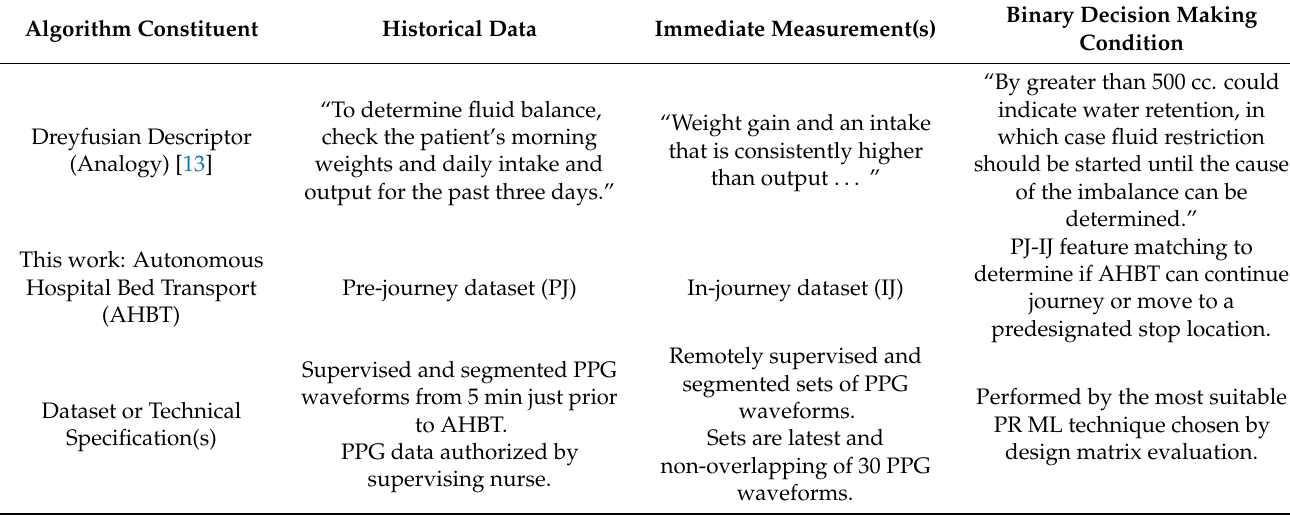
Table 1. Translation of Dreyfusian descriptor to proposed photoplethysmography (PPG) remote automated monitoring (RAM) machine learning (ML) algorithm constituents.